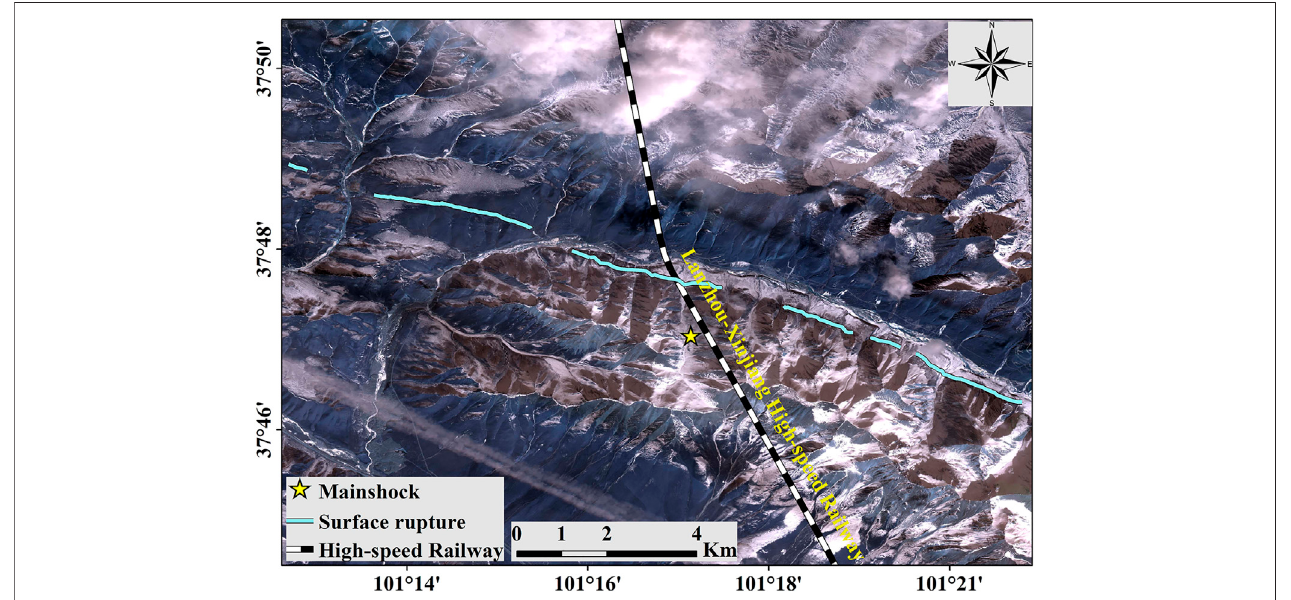
FIGURE 9 | The ground rupture of the 2022 Menyuan earthquake was traced from the GF-7 image acquired on 8 January 2022.